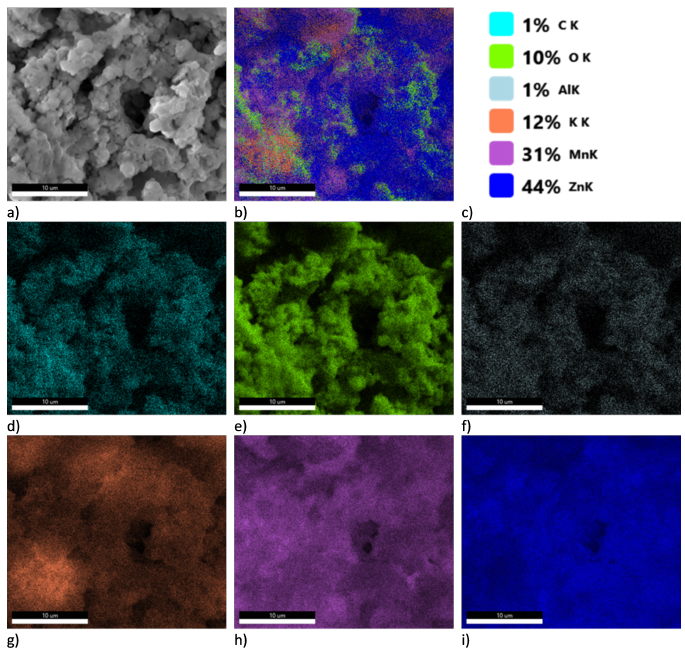
Figure A5. Result of SEM-EDS analysis for sample Zn5. ( a )—SEM picture; ( b )—EDS map; ( c )— weight concentration %; ( d )—EDS map for C; ( e )—EDS map for O; ( f )—EDS map for Al; ( g )—EDS map for K; ( h )—EDS map for Mn; ( i )—EDS map for Zn.